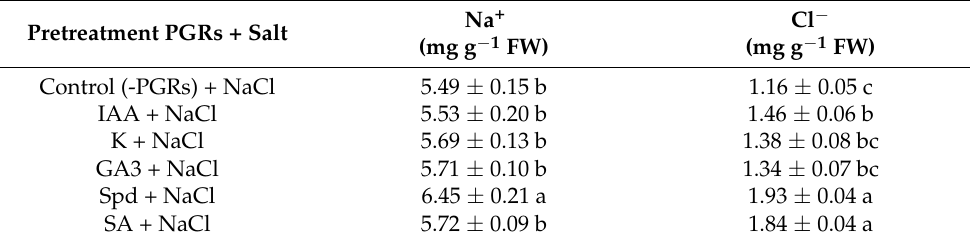
Table 2. Sodium and chloride determination from the leaf washing solution expressed per gram of freshly rinsed leaves of F. pulverulenta in response to pretreatment PGRs with salt (300 mM NaCl), after 52 days of culture. The values represent means ± SE ( n = 4). Different letters represent significant differences among pretreatments, according to Tukey’s test ( p ≤ 0.01) .